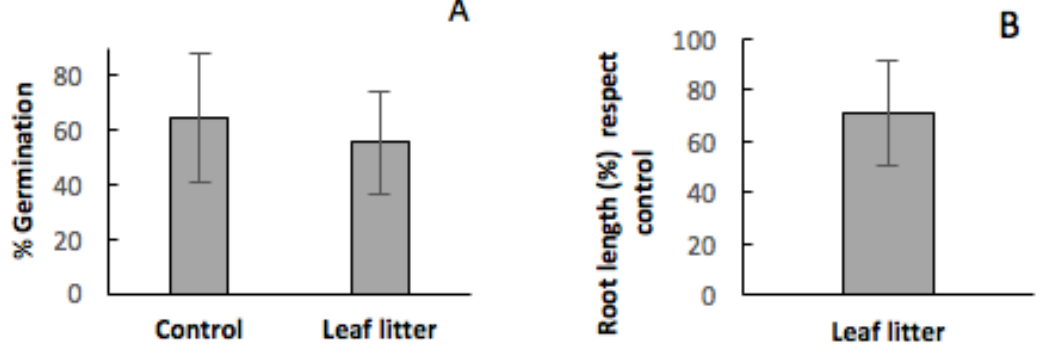
Figure 5. Effect of the presence of leaf litter from C. ladanifer on germination percentage (panel ( A )) and root length with respect to the control (panel ( B )). These parameters were quantified as the mean of all the analysed species.